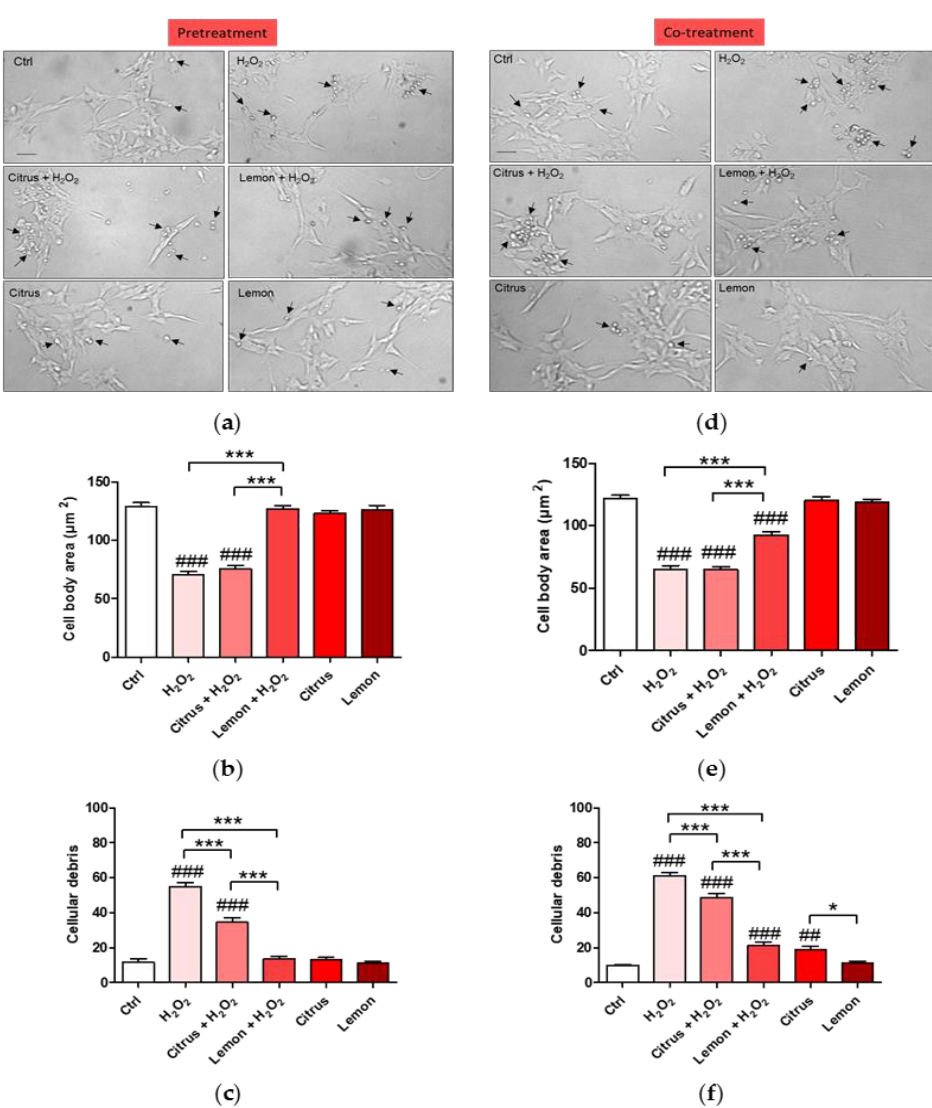
Figure 3. Effects of commercial (citrus) and lemon IntegroPectin (lemon) pectins on neuronal cell morphology in pretreatment and co-treatment: ( a ) Representative morphological images of the pretreatment of untreated cells (Ctrl) or treated with pectins or with H 2 O 2 alone or in combination with pectins; examples of cell debris are indicated by arrows; ( b ) Histogram of the pretreatment of untreated cells (Ctrl) or treated or with H 2 O 2 alone or in combination with pectins, cell body area; ( c ) Histogram of the pretreatment of untreated cells (Ctrl) or treated or with H 2 O 2 alone or in combination with pectins, number of cells debris; ( d ) Representative morphological images of co-treatment of untreated cells (Ctrl) or treated with pectins or with H 2 O 2 alone or in combination with pectins; examples of cell debris are indicated by arrows; ( e ) Histogram of the co-treatment of untreated cells (Ctrl) or treated or with H 2 O 2 alone or in combination with pectins, cell body area; ( f ) Histogram of the co-treatment of untreated cells (Ctrl) or treated or with H 2 O 2 alone or in combination with pectins, number of cells debris. Bar: 50 µ m. Tukey test: ## p < 0.01, ### p < 0.001 as compared to control (Ctrl) group; * p < 0.05, *** p < 0.001.